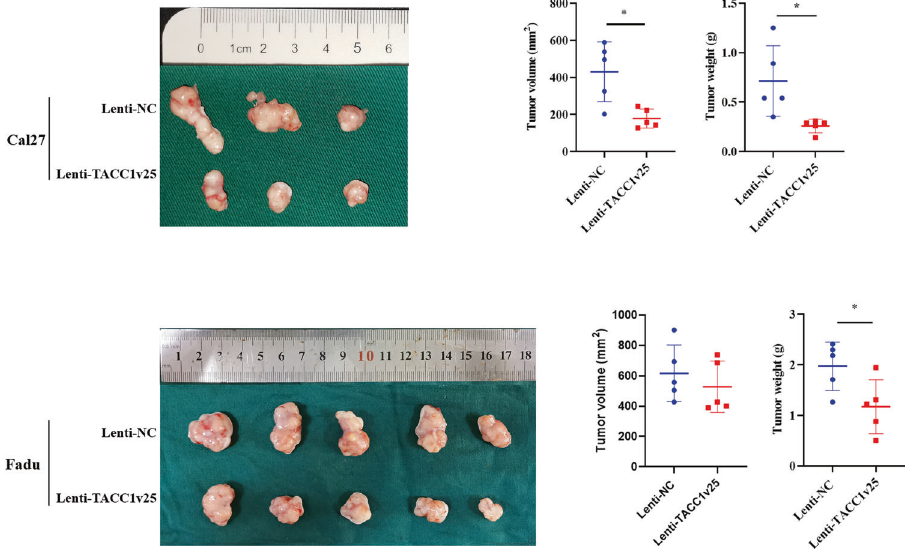
Fig. 7 TACC1v25 inhibits the tumour growth in vivo. The weight and volume of tumours in the Lenti-TACC1v25-Cal27 group are signi fi cantly less than those in the Lenti-NC-Cal27 group ( N = 5). In Lenti-TACC1v25-Fadu group, weight is signi fi cantly decreased, but there is no signi fi cant change in tumour volume. * P <